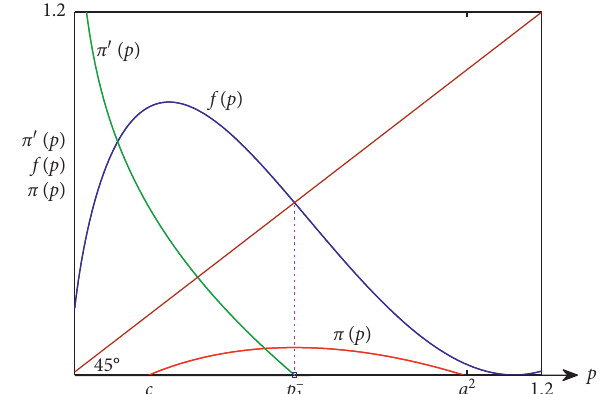
Figure 2: The shapes of the functions π ′ ( p ) , f ( b ) , and π ( p ) along with a line with 45 o . It is obvious that π ( c ) and π ( a 2 ) are vanished while max π ( p ) is obtained at p . The other parameters’ values are a � 1 , b � 0 . 2 ,k � 1